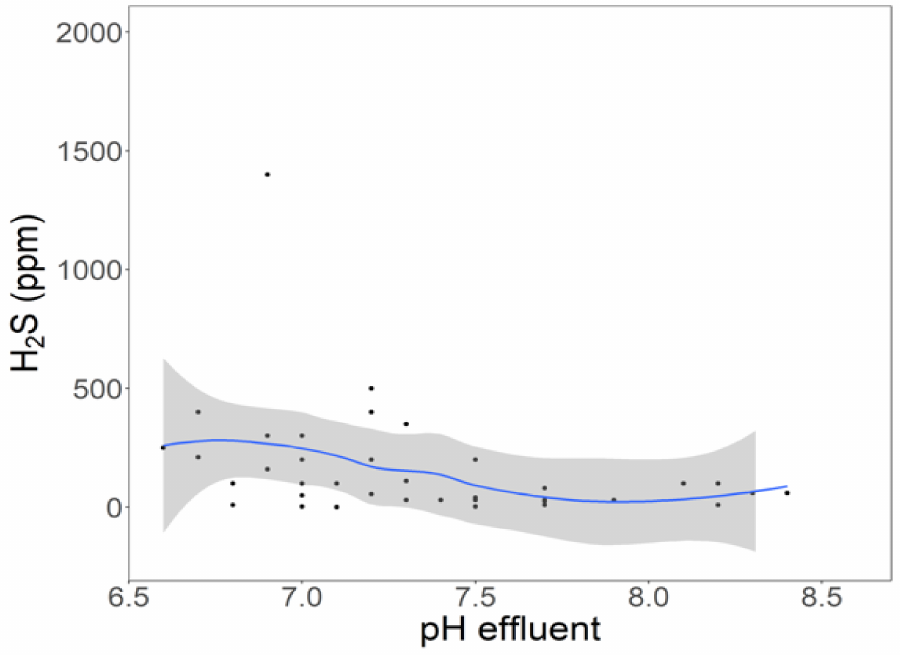
Figure 4. Effect of pH on the H 2 S content in the gas.